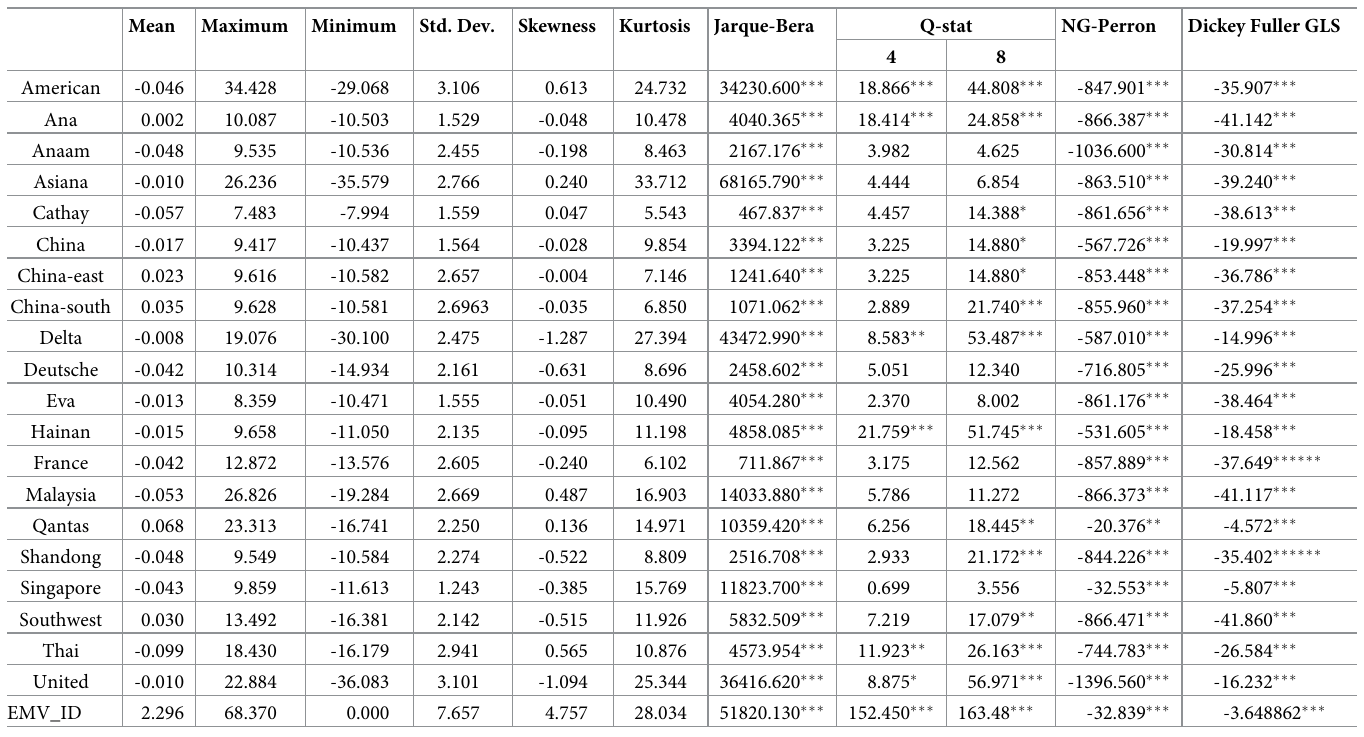
Table 1. Preliminary